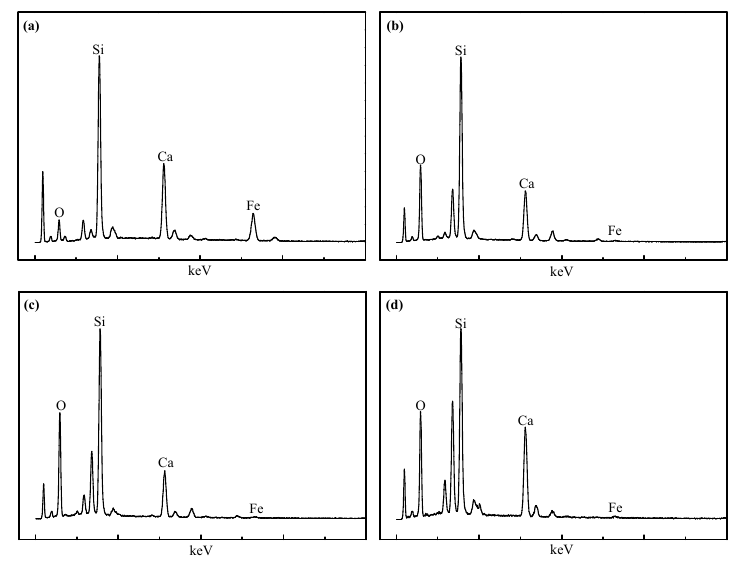
Figure 8. EDS analysis of different areas: ( a ) area G; ( b ) area H; ( c ) area K; and ( d ) area L.